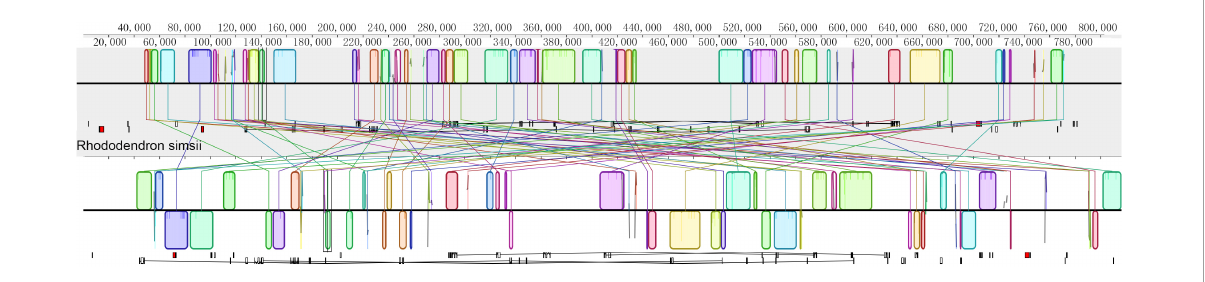
FIGURE4 Mauve visualization of mitochondrial genome-wide comparison between Rhododendron × pulchrum and R . simsii . [The progressive mauve alignment (in the Mauve program) shows the homologous blocks shared among the mitochondrial genomes, and it also connected these blocks with lines, indicating the corresponding position among the homologous blocks to visualize the gene arrangement].